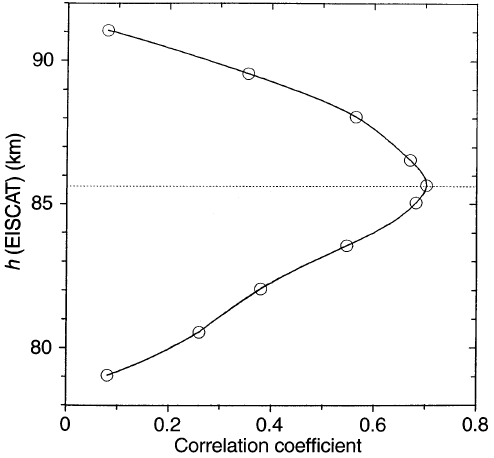
Fig. 8. Correlation between hourly SNR values measured with the ALOMAR SOUSY radar at different heights and data of the MF radar at a constant height ( h " 82 km)